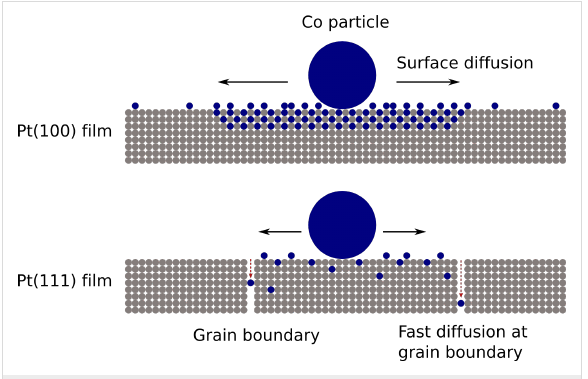
Figure 10: Proposed model of local alloying and diffusion of Co NPs on Pt films. Details are discussed in the text.